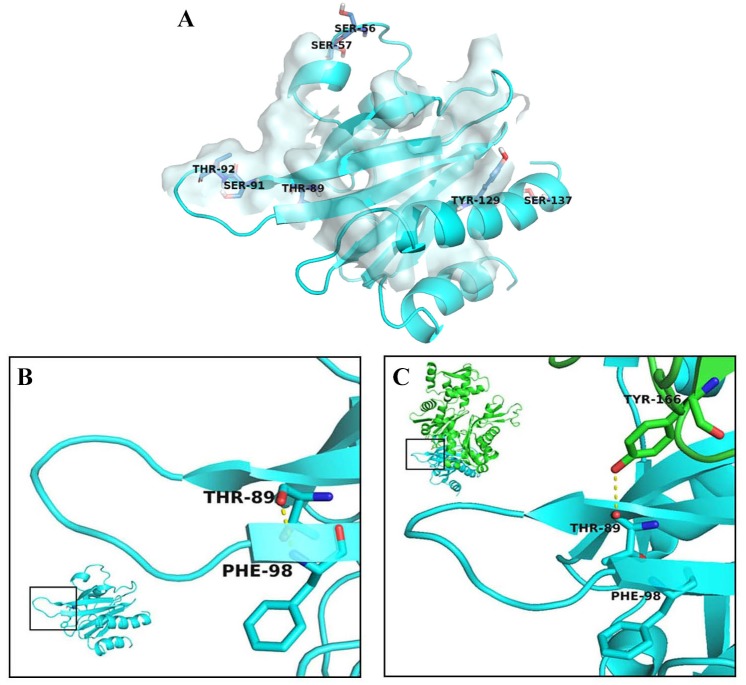
Molecular interactions of T89 of Pfn1.A) Actin-interacting surface of Pfn1 (Pfn1: blue; actin: grey); phosphorylatable residues of Pfn1 are indicated as sticks. B) In unbound Pfn1 (PDB 1PFL) T89 forms an intramolecular hydrogen bond with F98. C) In the Pfn1-actin complex (PDB 2BTF) an intermolecular hydrogen bond (dashed yellow line) is observed between T89 of Pfn1 (blue) and Y166 of actin (green).